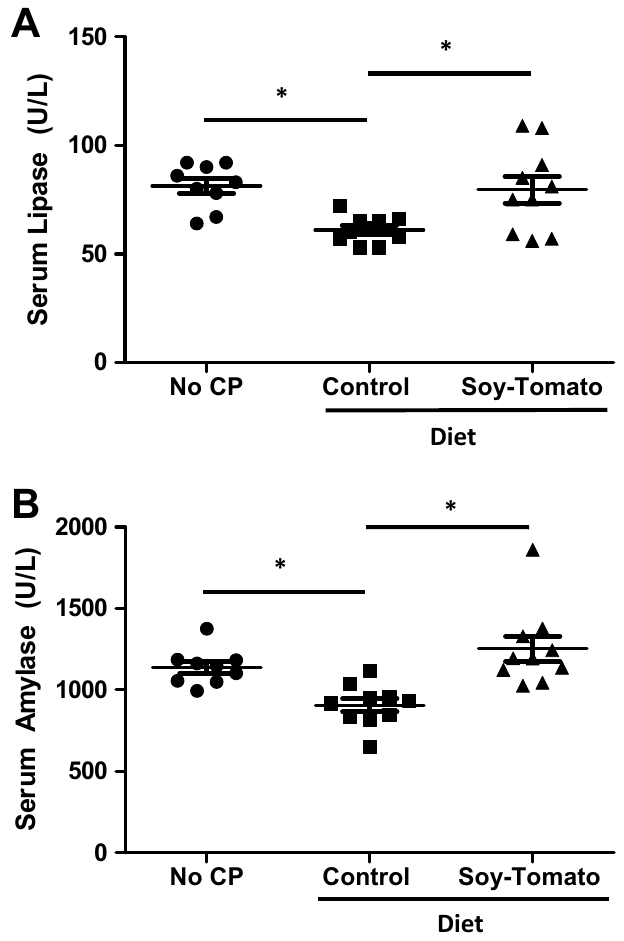
Figure 2. Serum lipase and amylase levels were restored in mice fed a soy-tomato enriched diet. C57BL/6 mice were injected intraperitoneally with 50 µg/kg caerulein (7 hourly injections, twice weekly) for 6 weeks. Mice across all groups were fed a control diet from the start. After 4 weeks of injections, one group was fed a soy-tomato enriched dietary intervention. At study endpoint, whole blood from mice was collected and serum was stored following centrifugation. Serum ( A ) lipase and ( B ) amylase were analyzed by the Alfa Wassermann VetAce analyzer. N = 5 mice/group (* p <